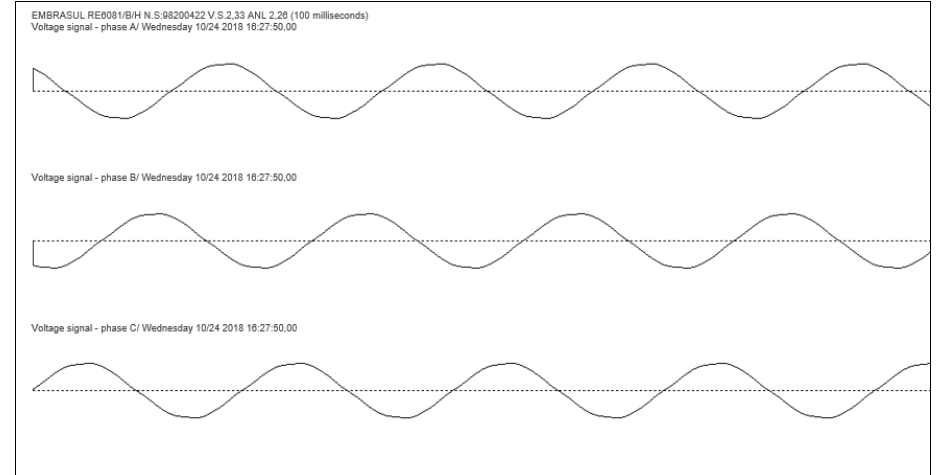
Figure 4: Voltage output from UPS